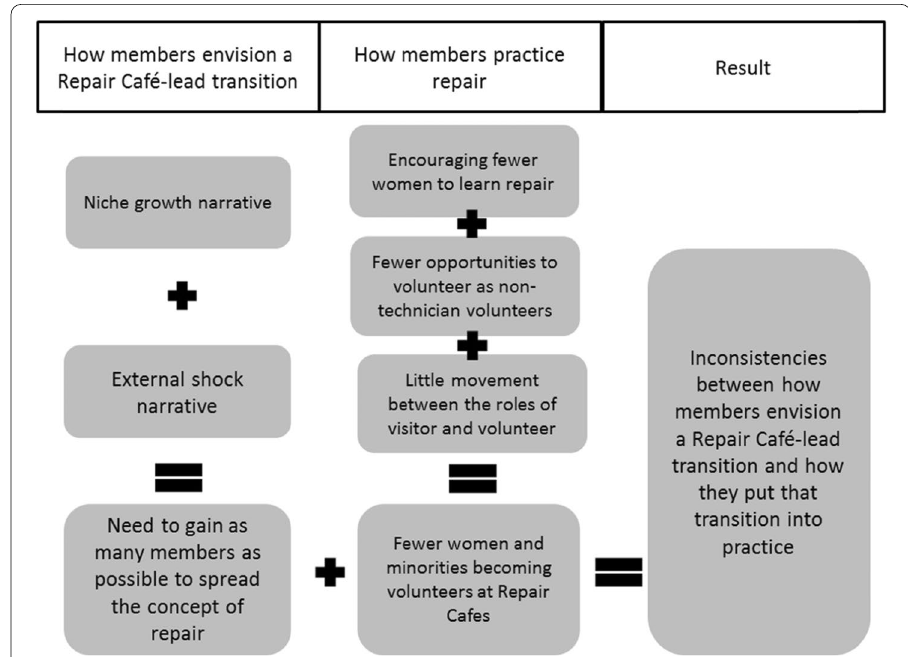
Fig. 5 How inconsistencies arise in the male dominated Repair